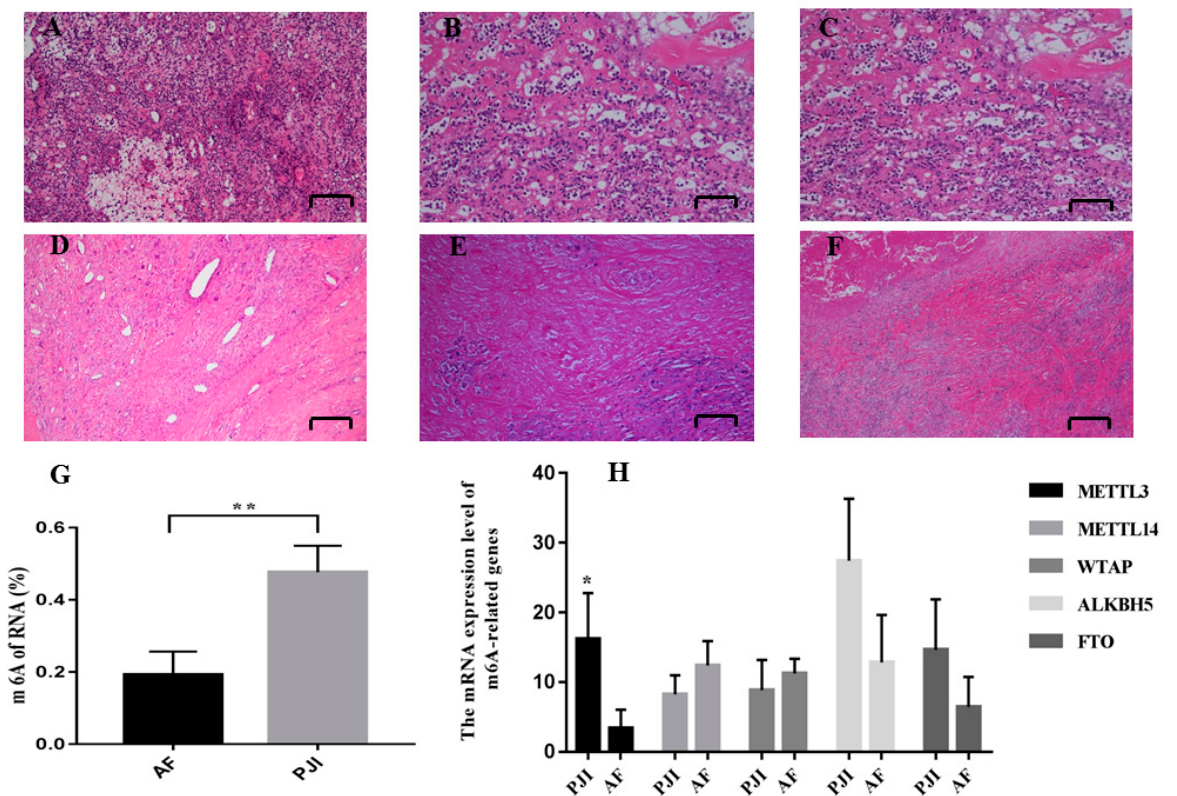
Figure 1. HE staining ( A – F ): inflammatory hyperplasia was observed in synovium of PJI, with inflammatory cells, plasma cell infiltration, and multinucleated giant cell reaction. The neutrophil counts > 50/HPF (high power filed). ( A – C ): PJI; ( D – F ): AF. The overall m6A level of PJI was higher than AF ( G ). The relative mRNA expression level of methylases and demethylases ( H ). * p < 0.05; ** p < 0.01.